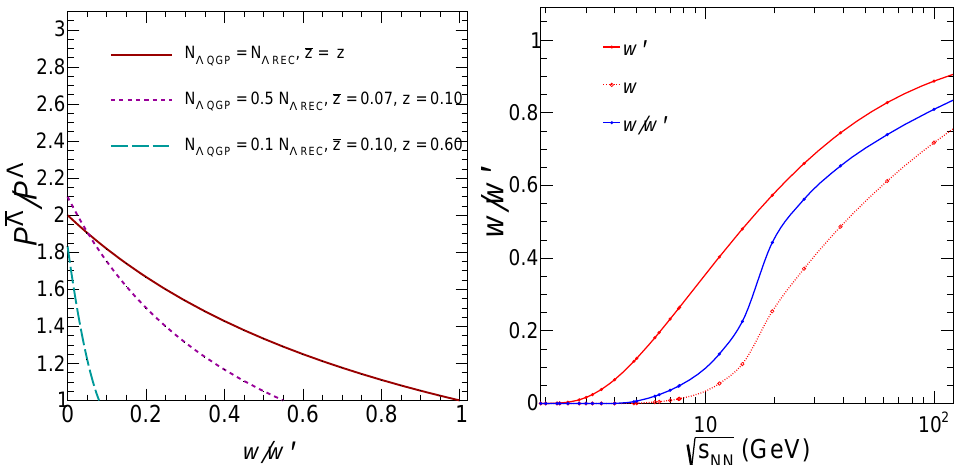
Figure 5. The panel on the left shows that the ratio P Λ / P Λ increases as w / w (cid:48) decreases. For small enough w / w (cid:48) , it achieves values larger than 1 in the case N Λ The panel on the right shows the ratio w / w (cid:48) as a function of the collision